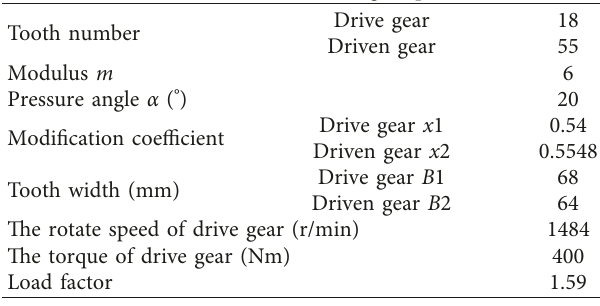
Table 1: Scheme of orthogonal experiment. Table 2: Parameters of gear pair.